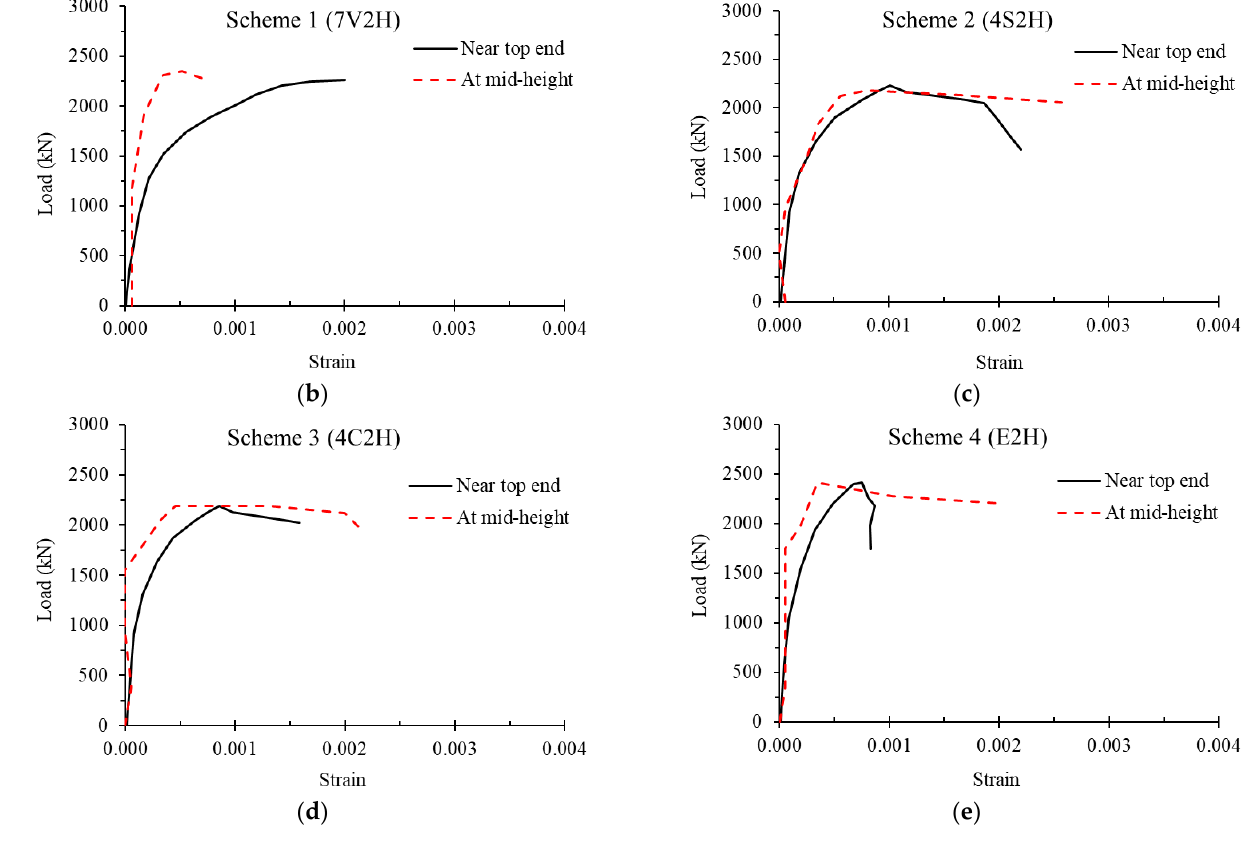
Figure 7. Load versus tensile strain in column ties for: ( a ) control column; ( b ) column strengthened using Scheme-1; ( c ) column strengthened using Scheme-2; ( d ) column strengthened using Scheme-3; and ( e ) column strengthened using Scheme-4. Table 3. Effect of strengthening schemes on lateral microstrains at ultimate and failure loads.